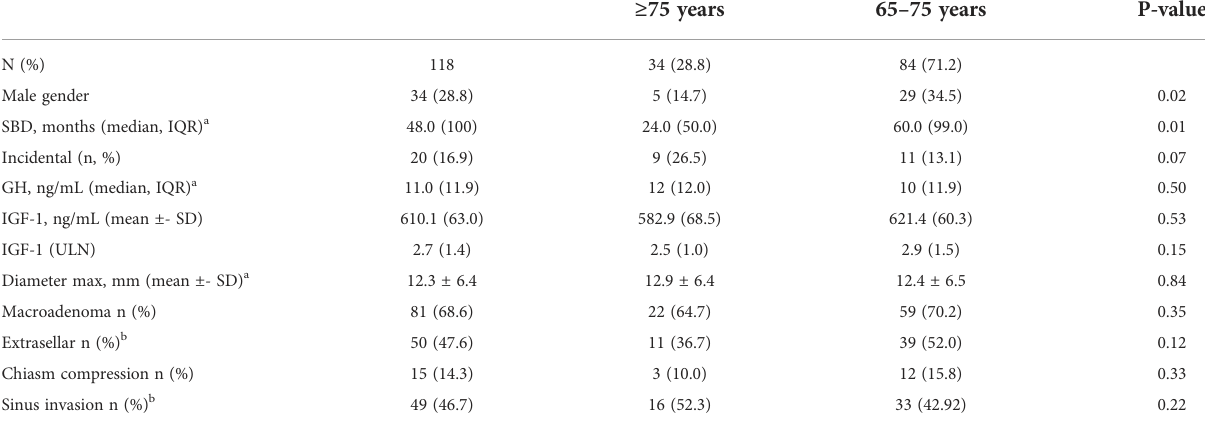
TABLE 2 Differences between patients older or younger than 75